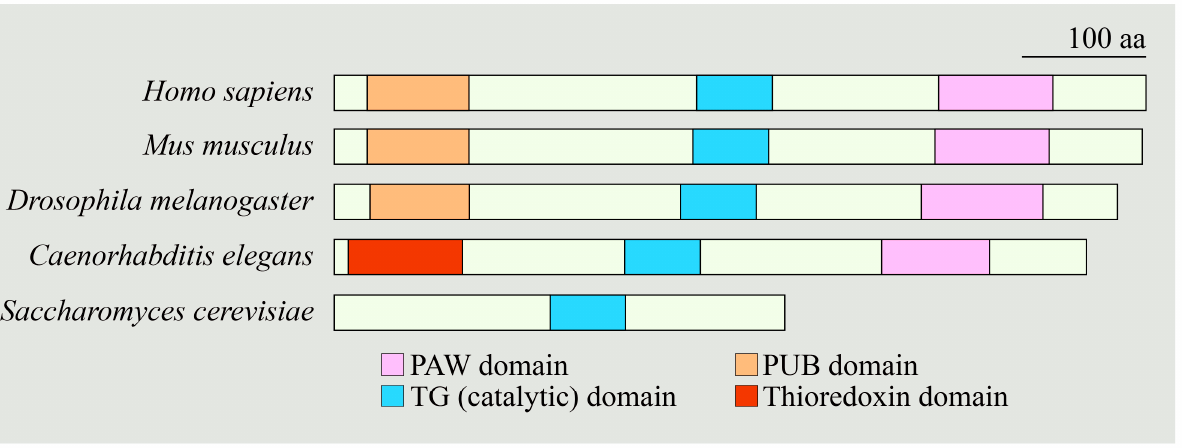
Figure 1. Schematic representation of N -glycanase 1 orthologs with domains present in the indicated species. aa, amino acid; PAW, a domain in PNGases and other worm proteins; PUB, a domain in PNGase/UBA or UBX-containing proteins; TG, transglutaminase-like.